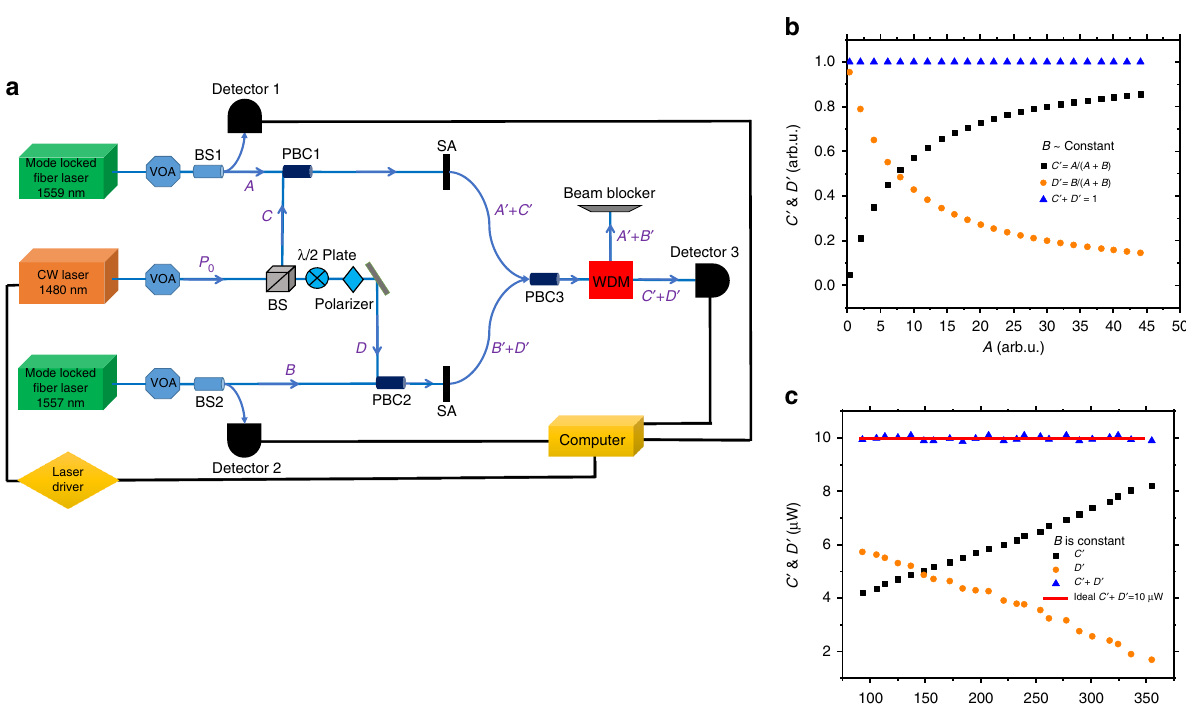
Fig. 6 Simulation and experimental results of normalization. a Experimental setup to normalize two powers A and B . The pump sources are two mode- locked fi ber lasers. The characteristics of these lasers are as follows: λ A = 1559 nm with 8 MHz repetition rate and 200 fs pulse width, and the other one λ B = 1557nm, 109 MHz, and 240 fs pulse width. The probe was a continuous wave (CW) diode laser λ = 1480 nm. Three variable optical attenuators probe (VOAs) and two beam splitters (BS1 and BS2) were used to monitor input powers to saturable absorbers (SAs). The polarization beam combiners (PBCs) were also used to combine the pump lasers powers with probe laser power with preserving their polarization. And a wavelength-division multiplexing (WDM) device was used in order to separate the modulated probe laser from the modulated pump lasers (see Methods for detail). b Simulated result to normalize two numbers A and B where we assume B is constant. c Experimental result to normalize two powers. In both b , c , the feedback-loop system adjusts the modulated power of C ′ + D ′ to remain